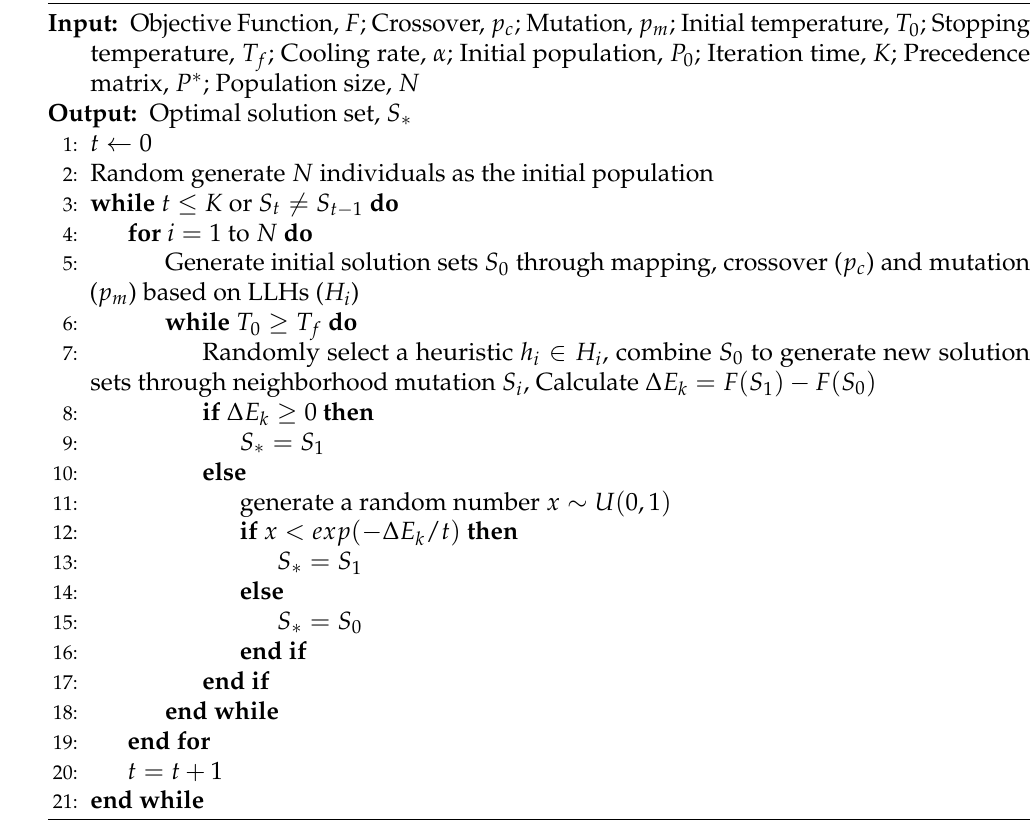
Algorithm 1 Proposed SA based